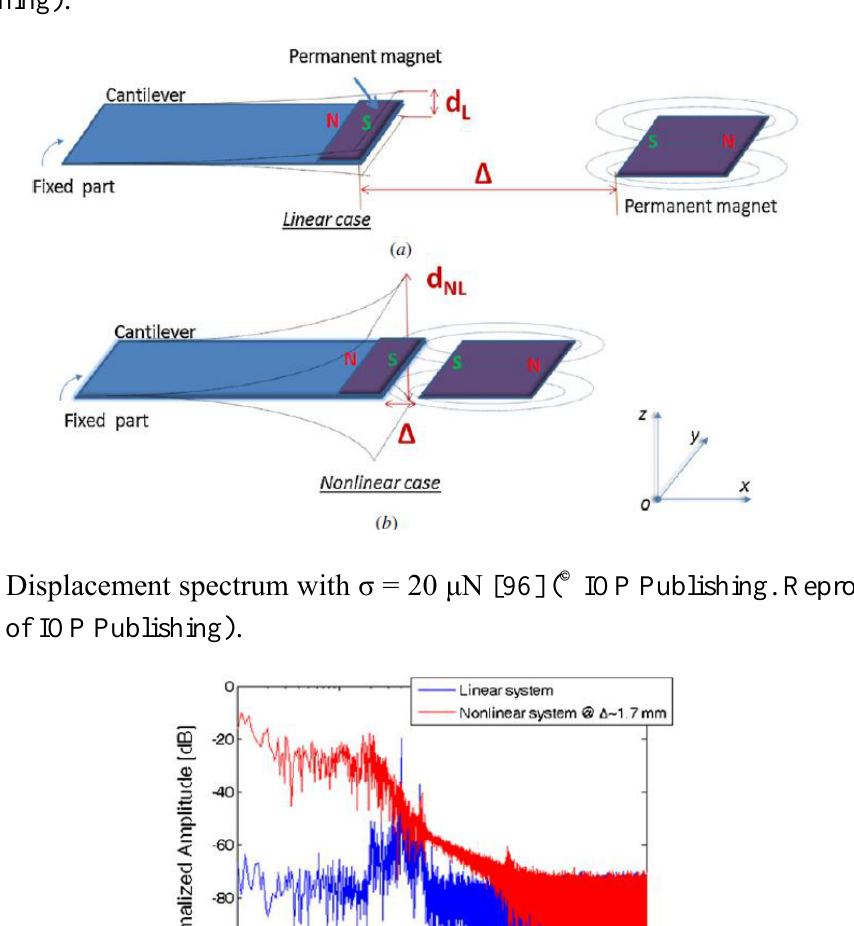
Figure 24. Nonlinear cantilever [96] ( © IOP Publishing. Reproduced by permission of IOP Publishing).